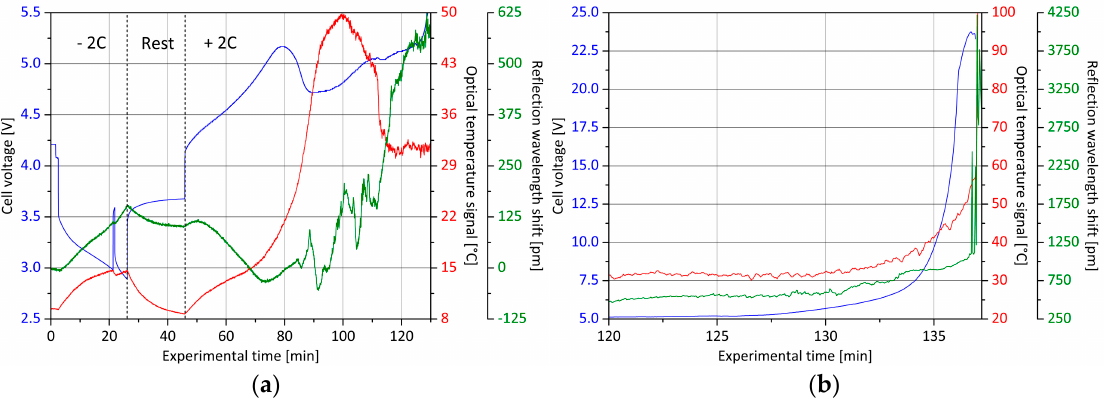
Figure 14. Overcharge experiment with the surface Bragg grating integrated lithium ion battery cell: ( a ) After a discharge and resting period, the cell is charged with 2C and monitored in terms of cell voltage (blue curve), external temperature (red curve) and internal optical sensor signal (green curve); ( b ) during the second section, the cell is electrically forced to go into thermal runaway. The experiment’s proceeding is recorded with a video that can be viewed in the supplementary material.